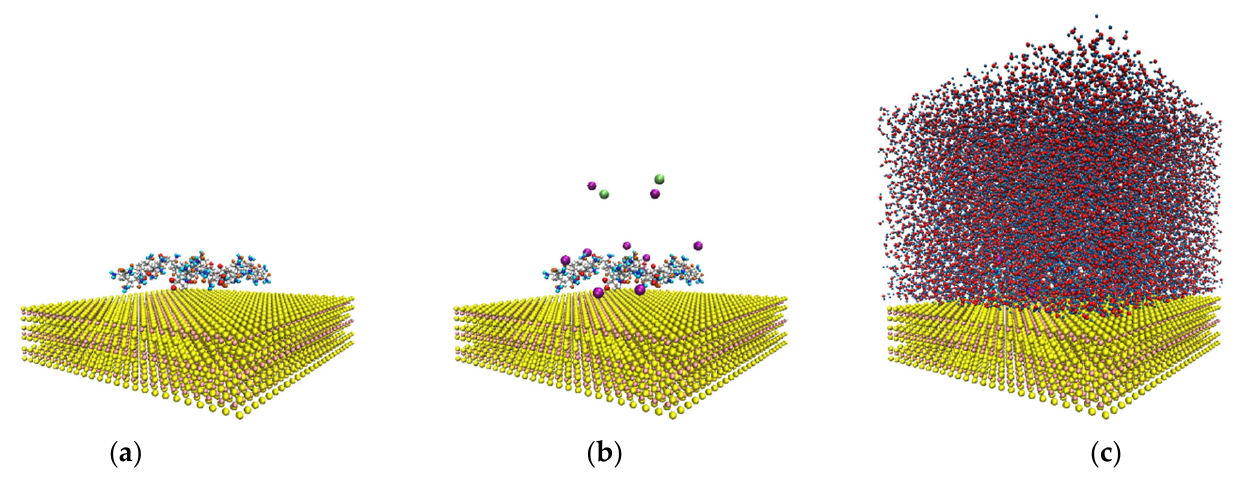
Figure 2. Molecular dynamics simulation setup. ( a ) Molybdenite face with two hydrolyzed poly- acrylamide (HPAM) molecules; ( b ) molybdenite face with two HPAM molecules and sodium and chlorine ions; ( c ) molybdenite face with two HPAM molecules, sodium and chlorine ions, and water molecules.